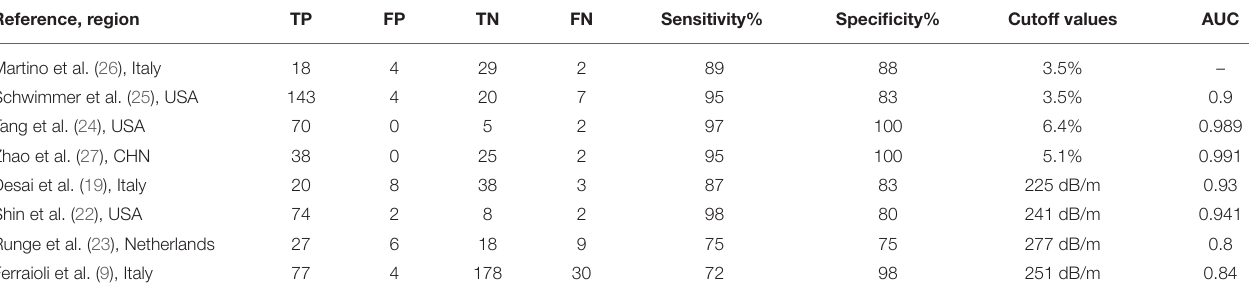
TABLE 2 | Study characteristics.